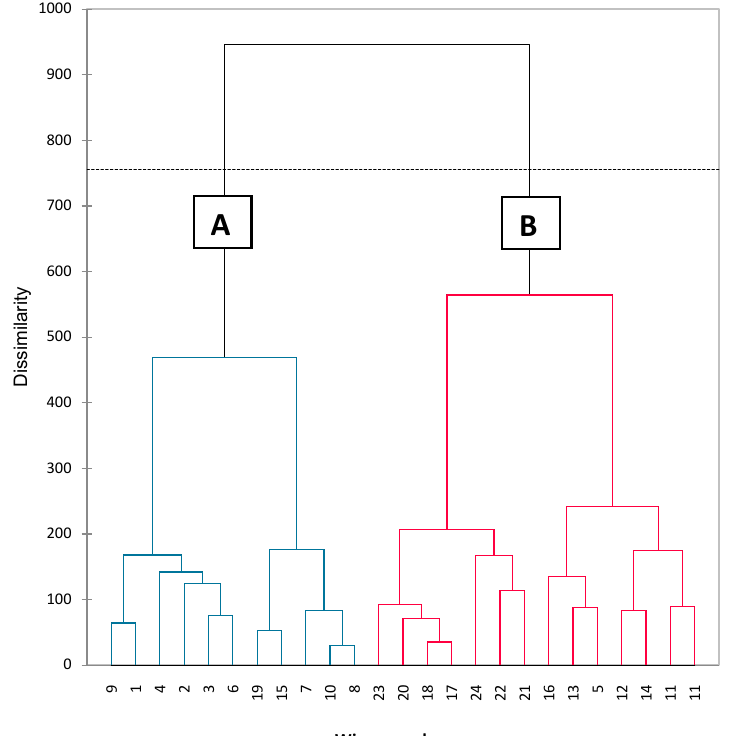
Figure 2. Agglomerative hierarchical clustering of the sorting task scores; the numbers indicate Prosecco wine samples, the letters A and B indicate clusters. The dashed line indicates the signifi- cance threshold. Table 5. Concentration (µg/L) of free volatile compounds in cluster 1 and cluster 2 wine samples. Odor threshold, mean, standard deviation (SD), statistical signi fi cance ( p -value), and level of signif-